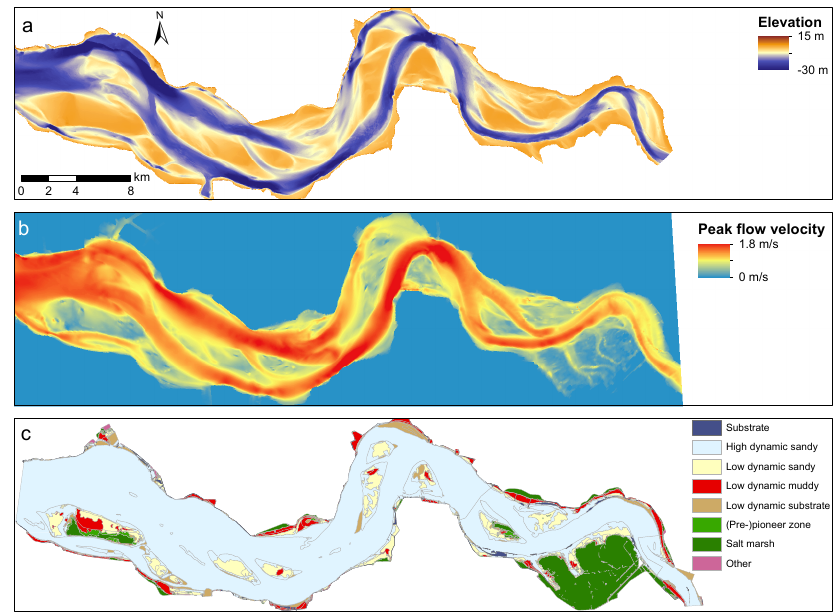
Figure 1. ( a ) bathymetry of the Western Scheldt in 2012 from the mouth (left) to the Dutch-Belgian border (right); ( b ) peak tidal flow velocities from a calibrated hydrodynamic model of Rijkswaterstaat (SCALWEST, [32]) for the bathymetry of the Western Scheldt in 2009 and ( c ) ecotope map of the Western Scheldt (2012). Bathymetry, hydrodynamic output and ecotope map were obtained from Rijkswaterstaat.